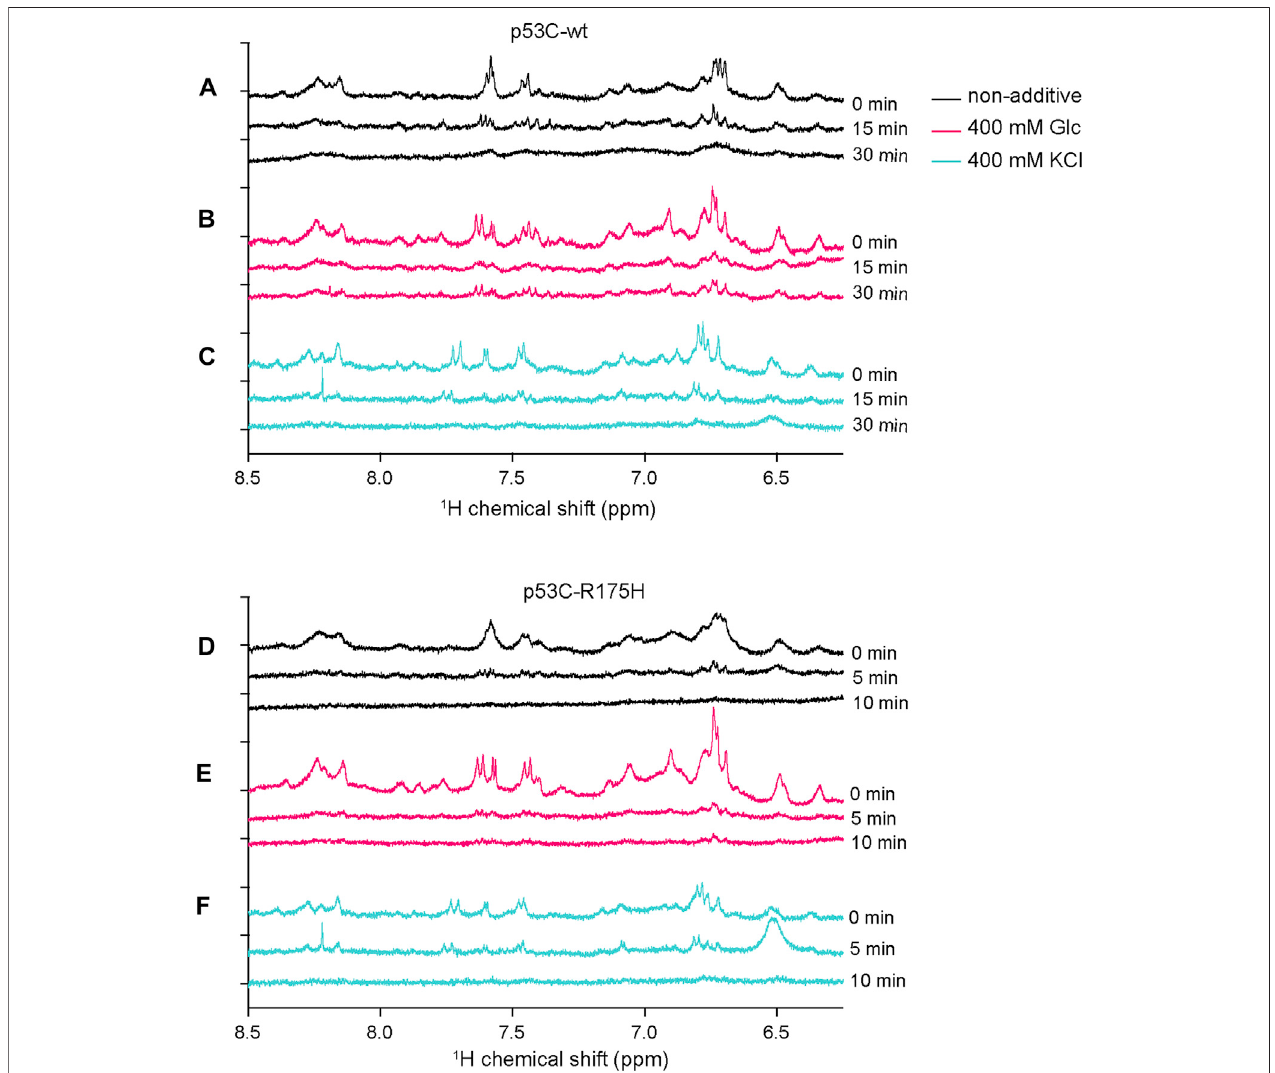
FIGURE 4 | The subtle structural changes associated with the aggregation of the p53C solution were monitored by 1D 1 H-NMR. (A – C) 1D 1 H-NMR spectra of p53C-wtat 0, 15, and 30 min, withoutadditives (A),with 400 mM deuterated Glc (B) ,or with 400 mM KCl (C) . (D – F) 1D 1 H-NMRspectra ofp53C-R175Hat 0, 15,and 30 min, without additives (D) , with 400 mM deuterated Glc (E) , or with 400 mM KCl (F)